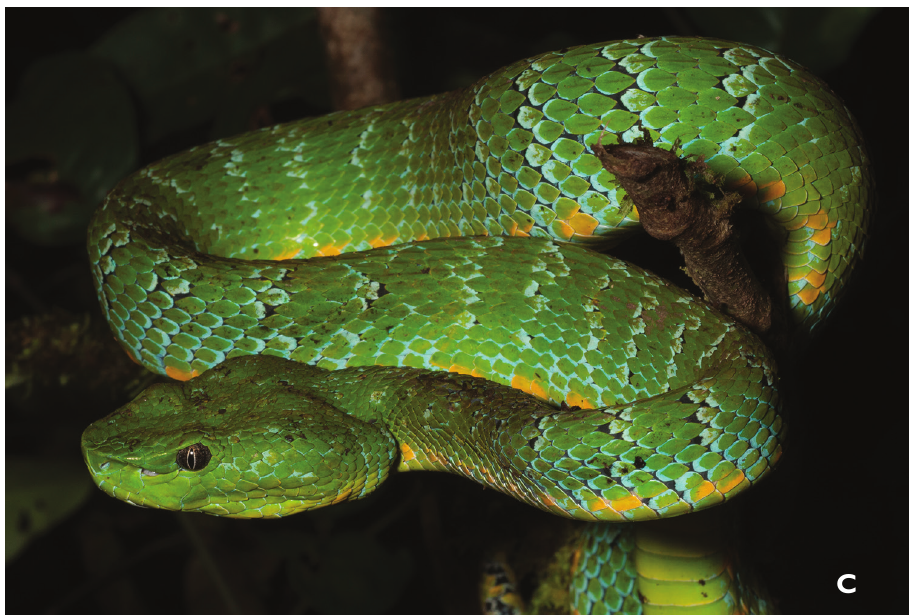
Figure 78. Continued. Trimeresurus cf. flavomaculatus green phase female ( C KU 334432), all from Mt. Hilong-hilong, Municipality of Remedios T. Romualdez, Agusan del Norte Province. Photos: